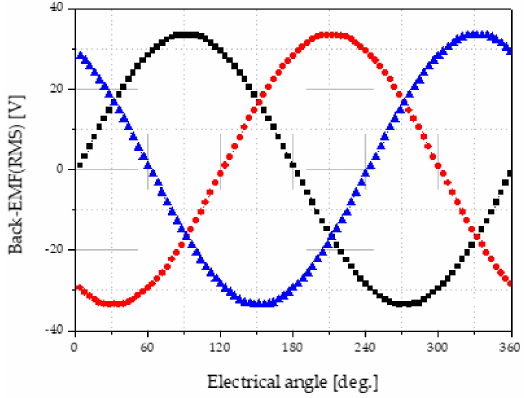
Figure 3. Back EMF of basic spoke type IPM